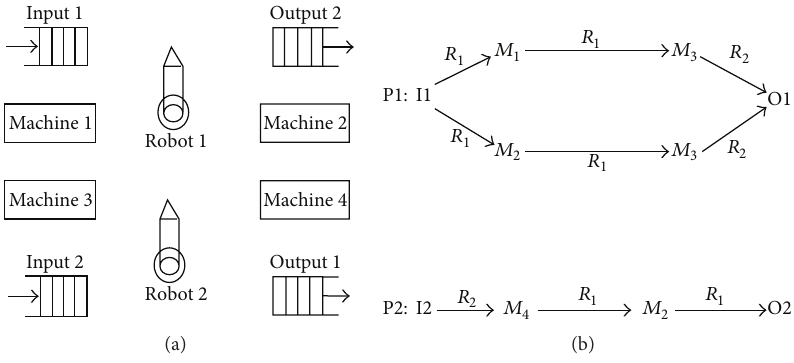
Figure 5: (a) Layout of an FMS and (b) routes of part types P1 and